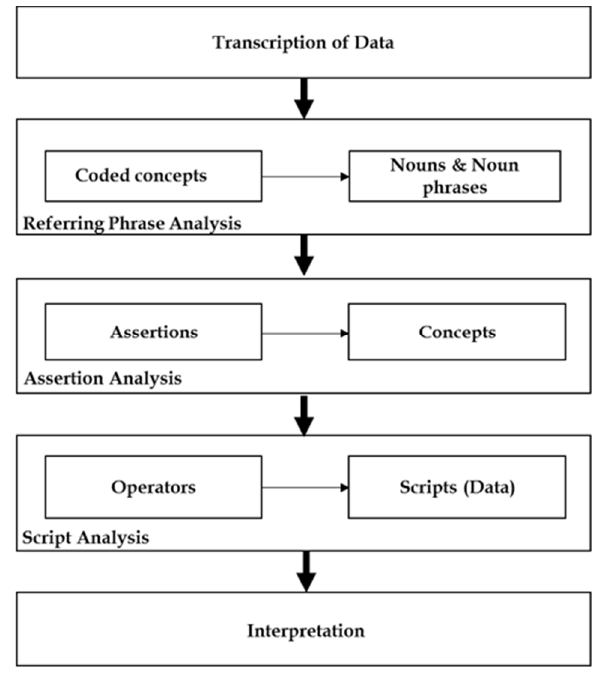
Figure 1. Protocol analysis framework